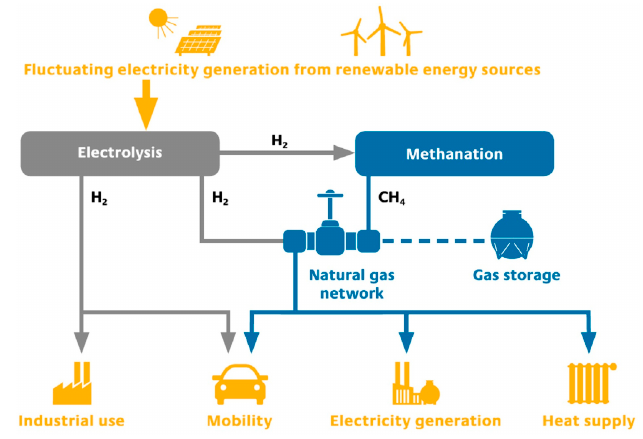
Figure 11. Power ‐ to ‐ gas (P2G) process and applications [109]. Figure 11. Power-to-gas (P2G) process and applications [109].